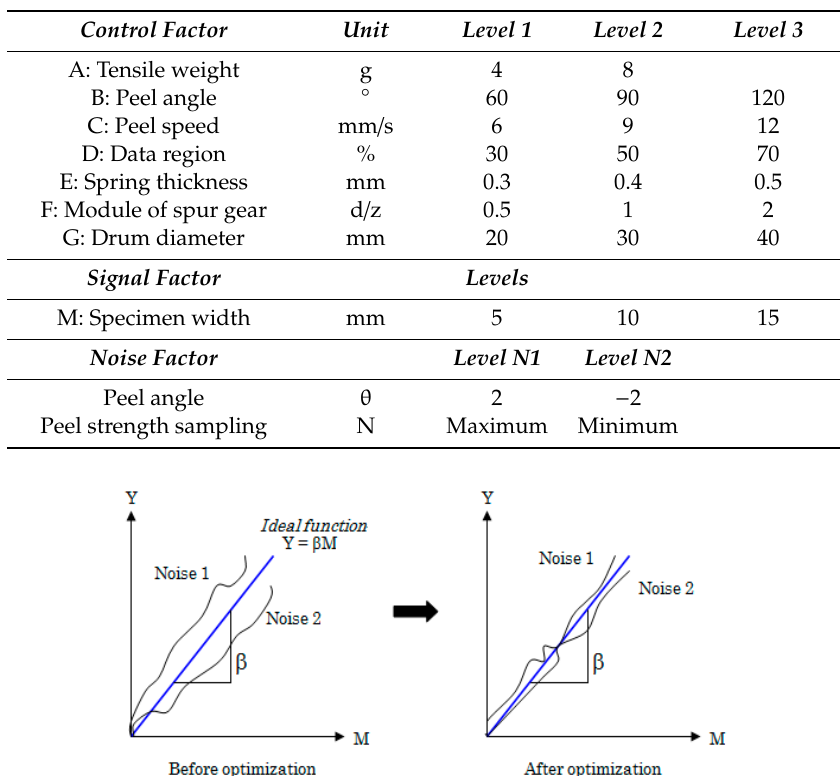
Table 1. Experimental setup.